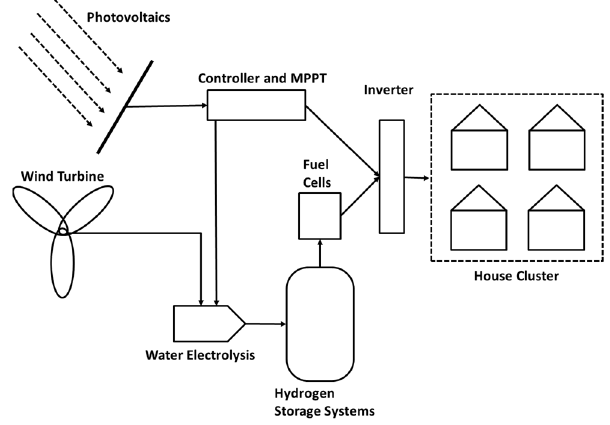
Figure 2. Schematic diagram of the grid-independent cluster of buildings with hydrogen energy storage.